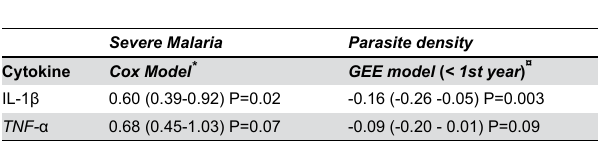
Table 5. Cox model on time to first severe malaria episode and GEE model on parasite